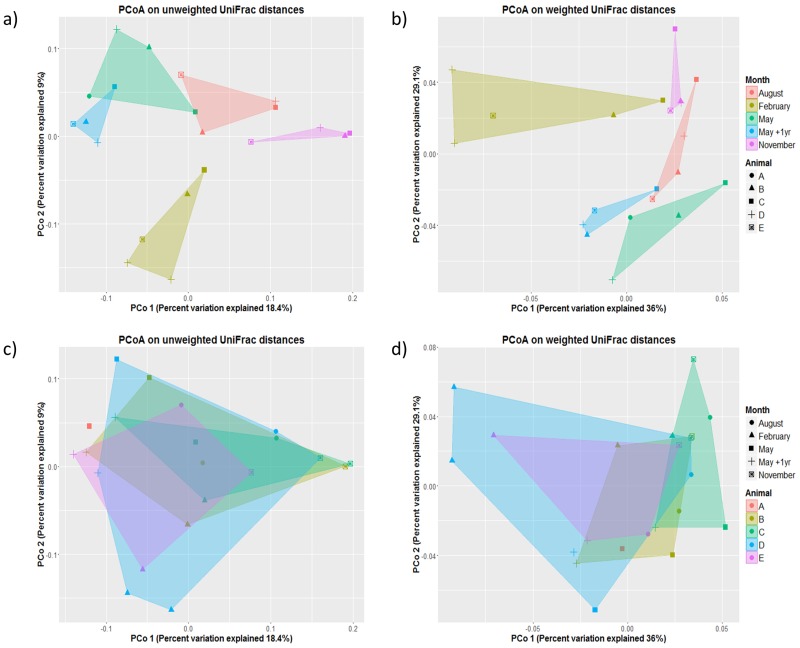
PCoA of individual samples colored by a, b) month and c, d) animal.Plots were generated using the a, c) unweighted and b, d) weighted versions of the Unifrac distance matrix.